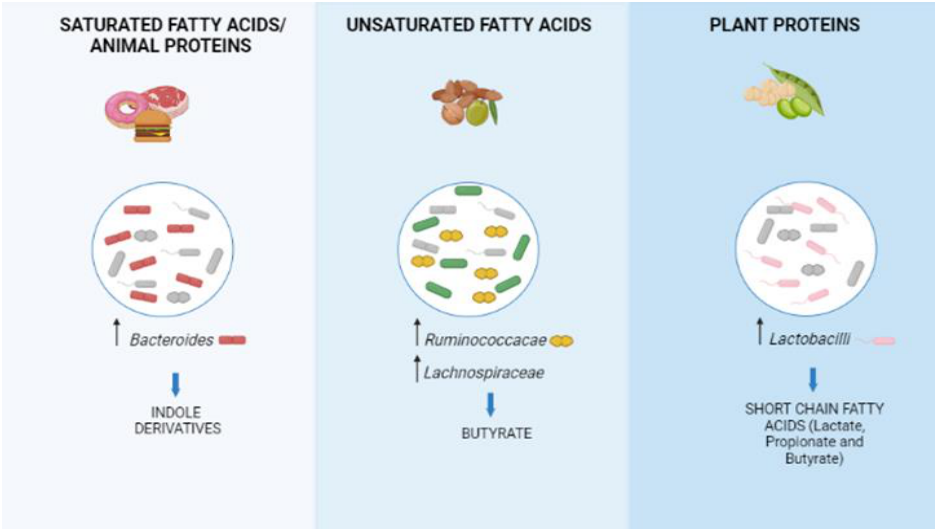
Figure 4. Influence of diet on microbiota composition. Saturated fatty acids and animal protein consumption increases the risk of cardiovascular diseases; unsaturated fatty acids and plant protein consumption protect against inflammation.